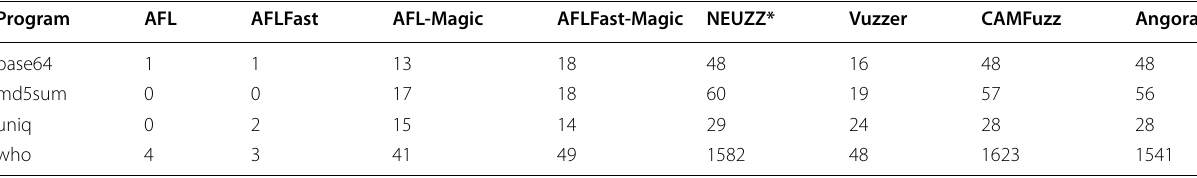
*We use the experiment results from the paper of NEUZZ since it is not open-sourced